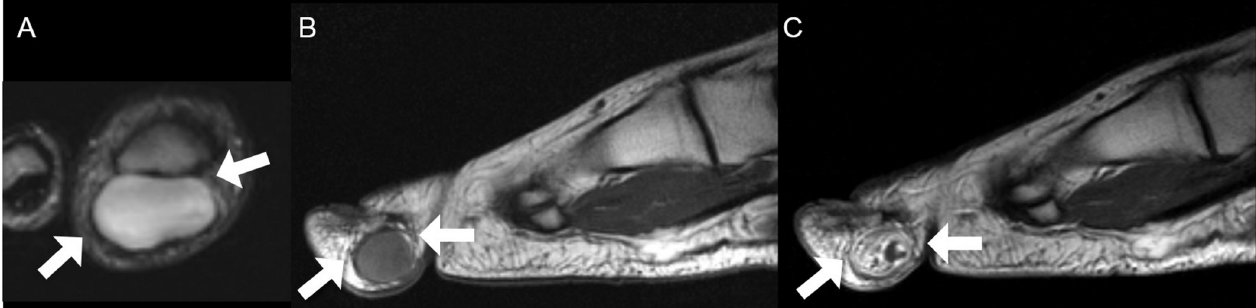
Fig 2. A 15-year-old woman with digital neurofibroma on the plantar side of the 1 st distal phalanx of the foot. ( A) On axial T2-weighted image, the mass shows mild lobulation and bright SI similar to fluid (arrows). ( B) On sagittal T1-weighted image, the mass shows mild hyperintense SI compared to the skeletal muscle (arrows). ( C) On sagittal contrast-enhanced T1-weighted image, the mass shows heterogeneously intense enhancement (arrows). This image characteristic correlates well with other reported cases of neurofibroma as iso or slightly hyperintense tissue on T1-weighted images, mildly or markedly hyperintense to skeletal muscle signals on T2-weighted image, and heterogeneous enhancement [18, 19]. SI , signal intensity.